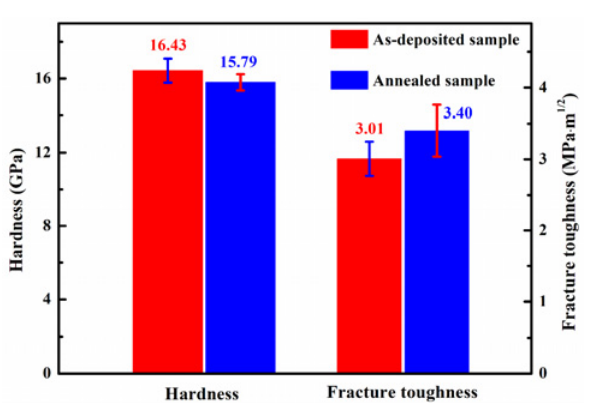
Fig. 10 Hardness and fracture toughness of the additively manufactured Al 2 O 3 /GdAlO 3 /ZrO 2 eutectic ceramic before and after the annealing